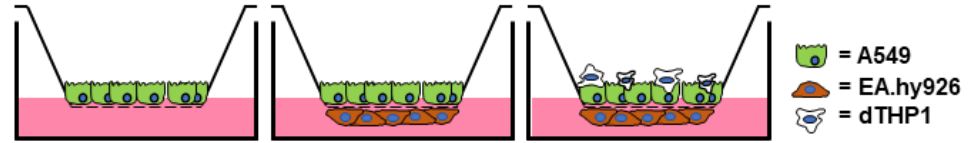
Figure 1. Scheme of mono-, co-, and triculture lung models of A549, EA.hy926, and dif- brane